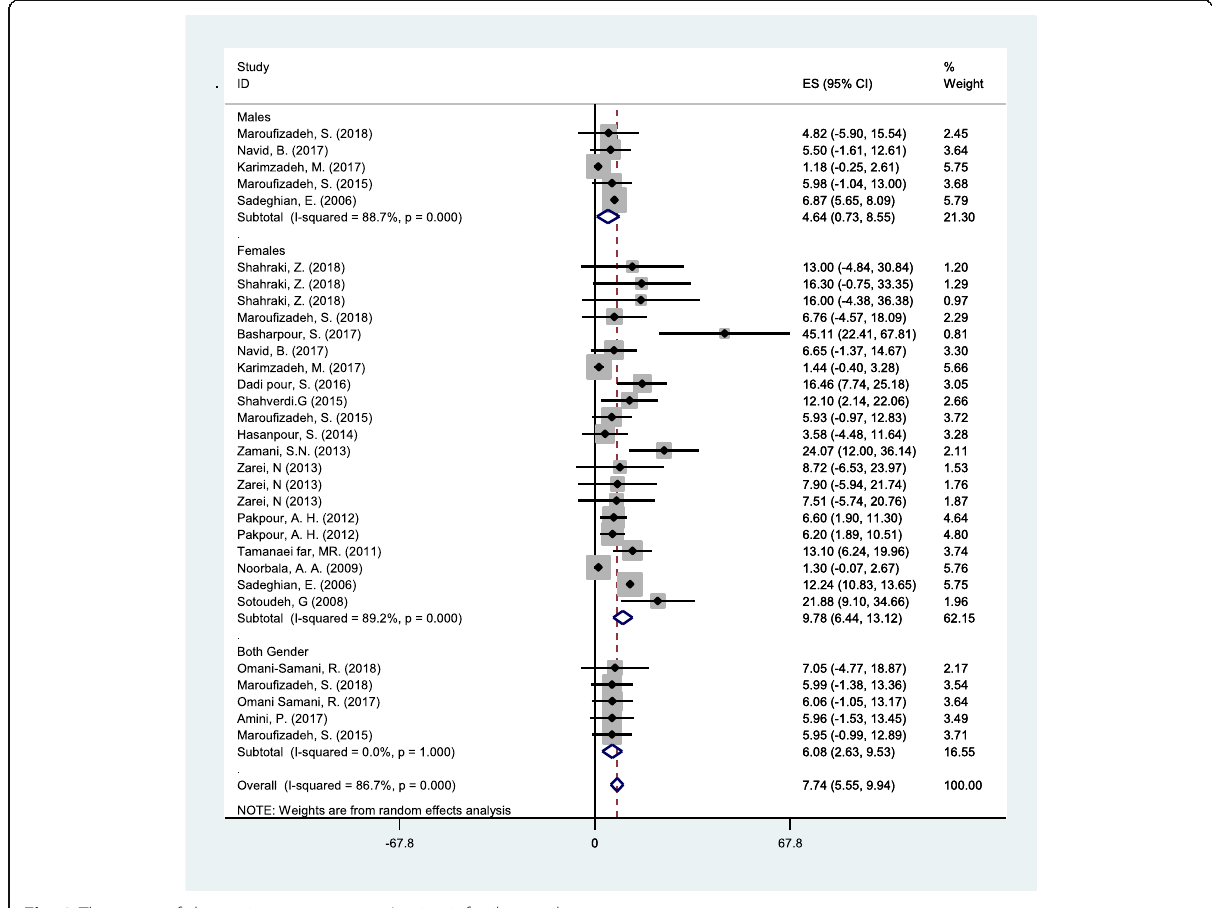
Fig. 3 The mean of depression score among Iranian infertile couples